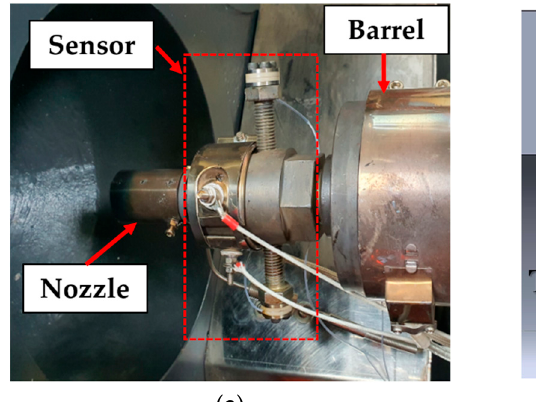
Figure 3. Measurement system.